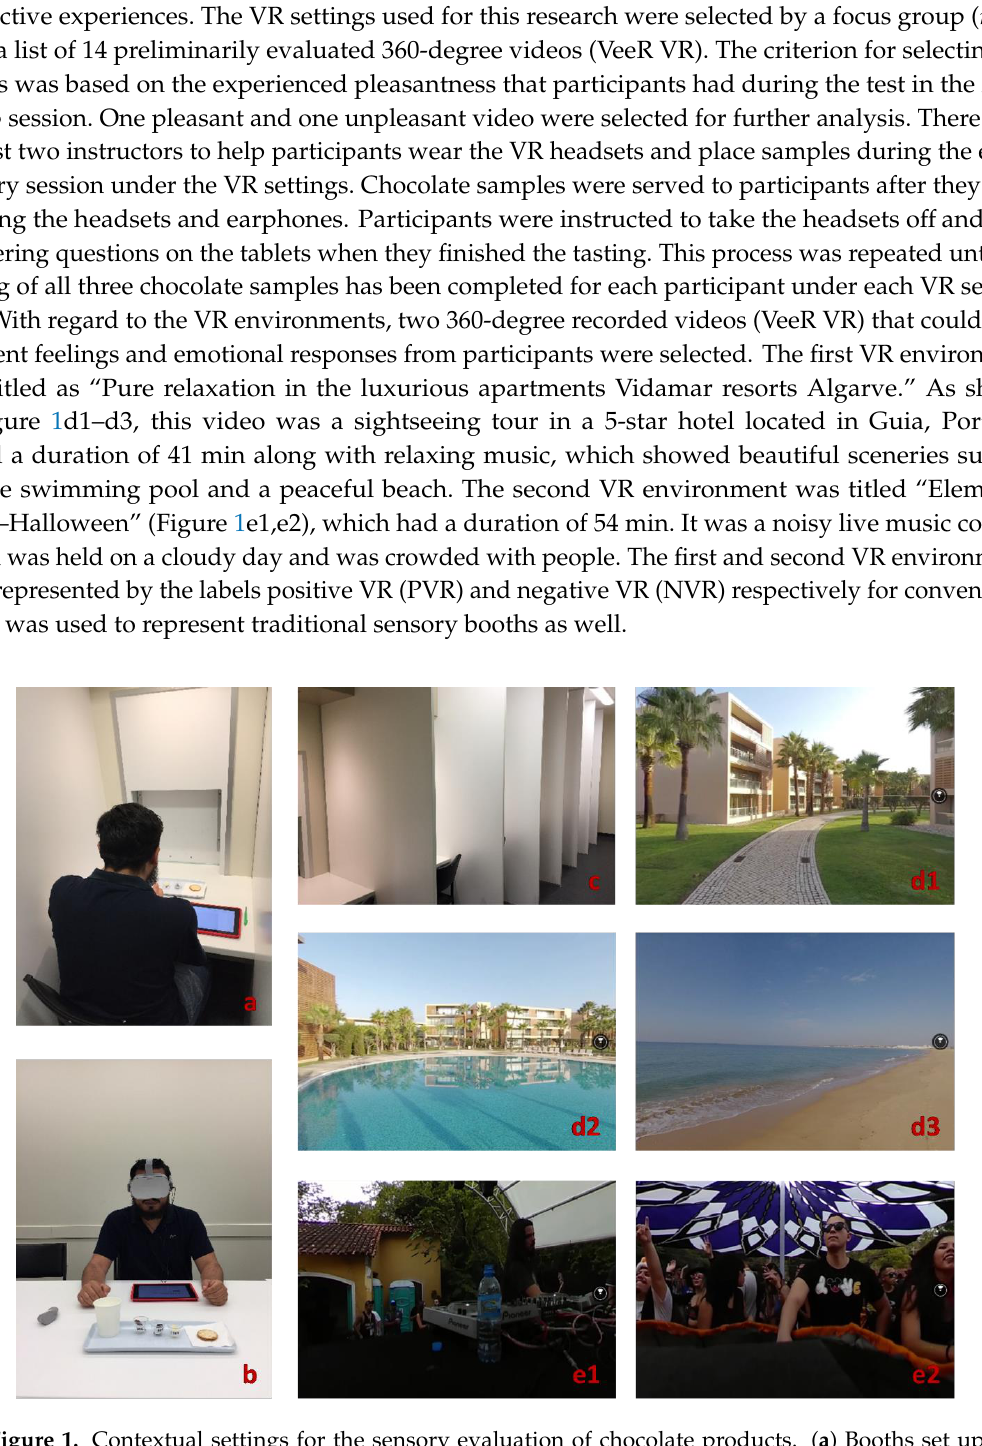
Figure 1. Contextual settings for the sensory evaluation of chocolate products. ( a ) Booths set up; ( b ) Virtual reality (VR) set up; ( c ) Sensory booth setting; ( d , 1 – 3 ) Positive VR setting; ( e , 1 – 2 ) Negative VR setting. VR environments were obtained from the VeeR VR app (VeeR VR, San Francisco, CA, USA).